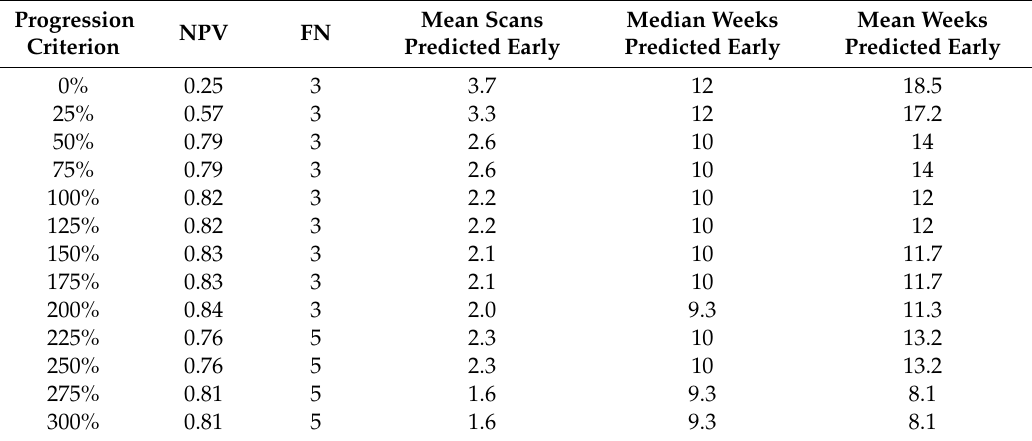
Table 2. Prediction results of various progression criteria. Progression is defined based on predicted T1post tumor volume relative to nadir. Each progression criterion is defined by a threshold (x% increase in T1post tumor volume from nadir) above which progression is called. The optimal progression criterion is found to be 200% based on maximizing the negative predictive value (NPV). We also report the average number of false negatives (FNs) and how early we predict progression based on the average number of scans and weeks before actual